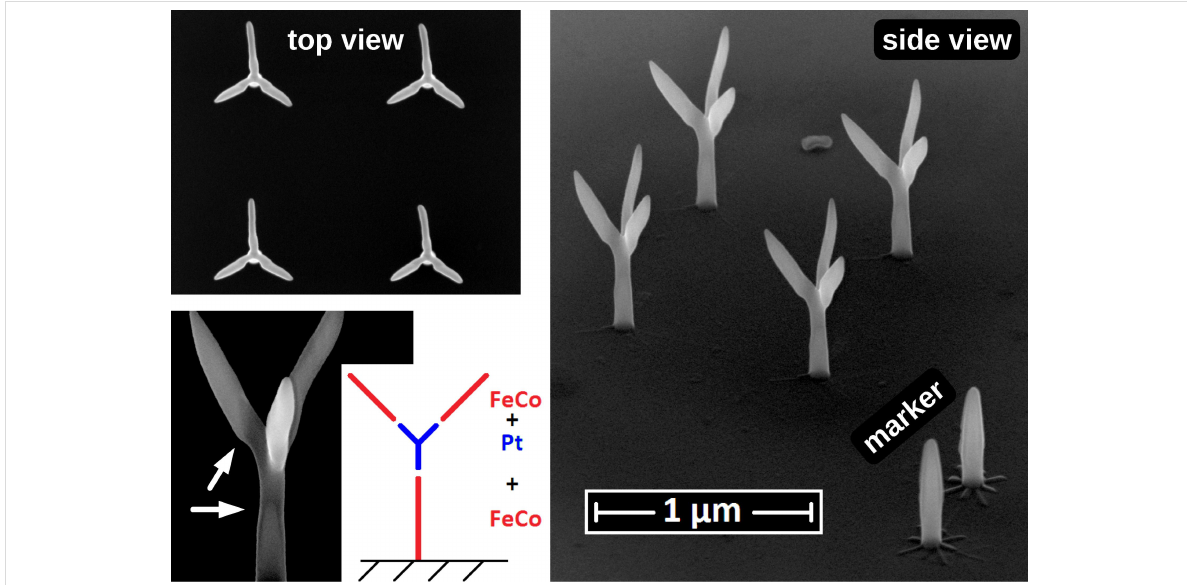
Figure 13: 2 × 2 array of nanotrees consisting of a root and branches deposited with the CoFe precursor and a connecting node in the middle of each tree deposited with the Pt precursor. In the bottom right corner two pillars, serving as markers, are visible. On each pillar base a thinly-defined star pattern is visible, which was deposited and used for aligning the second (Pt(C)) and third (CoFe) structure elements. The pillars are part of the first pattern file. Every star is part of either the second or the third pattern file. They can be defined by a single line in the geof. Beam current: 13 pA.